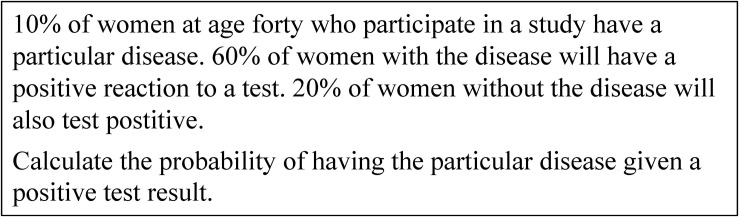
A typical Bayesian situation in an unspecific medical context (Johnson and Tubau, 2015, p. 3).